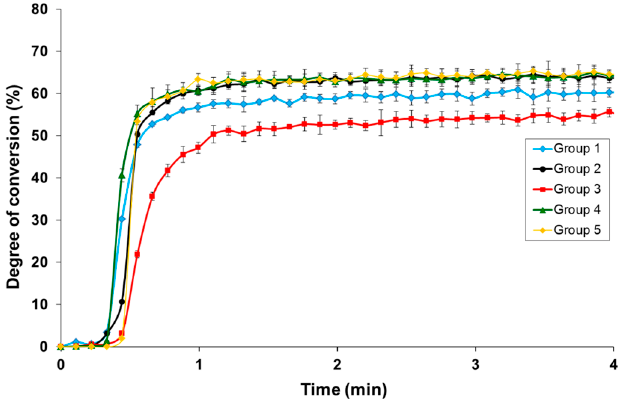
Figure 1. Degree of conversion in the five different groups. The maximum for Groups 2, 4, and 5 were 64.49%, 65.95%, and 66.87%, respectively. Group 3, lacking tertiary amine, had the lowest value among them.